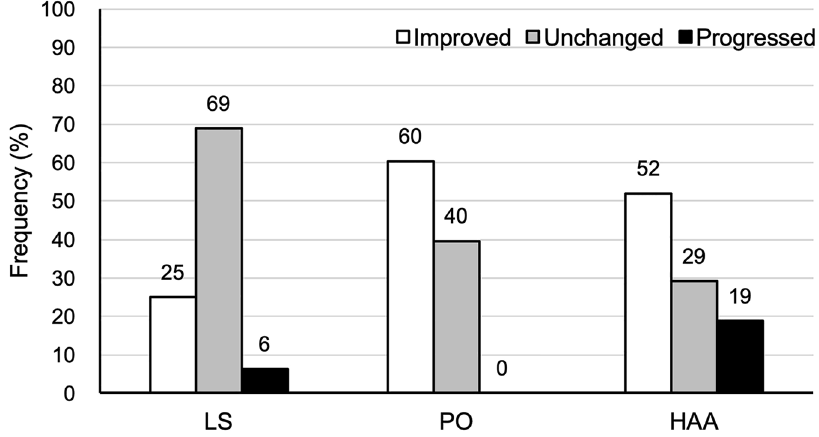
Figure 2. Distribution of the improved, unchanged, and progressed changes in the coronal lumbar-pelvic- femoral alignment. LS , lumbar scoliosis; PO , pelvic obliquity; HAA , hip adduction angle.